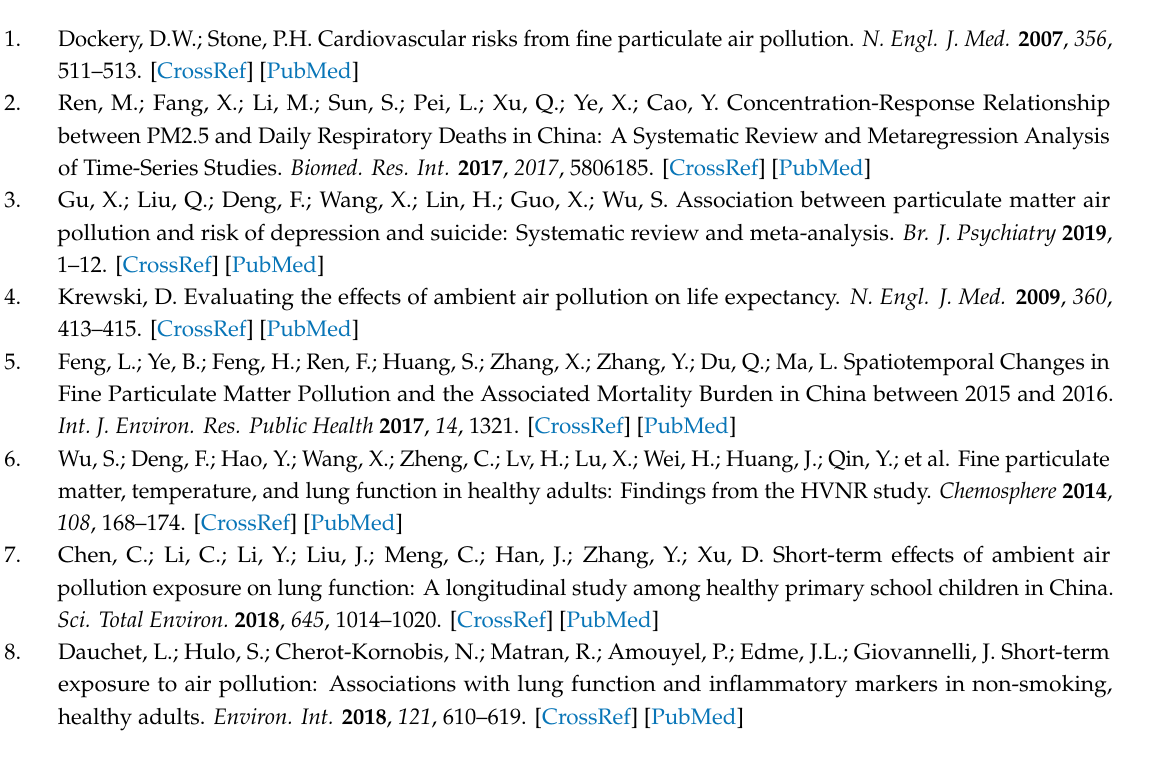
Table S1: Average concentrations of pollutants and meteorology variables in each season ( µ g / m3). Table S2: Spearman correlation coe ffi cients matrix among indoor and outdoor pollutants and meteorology